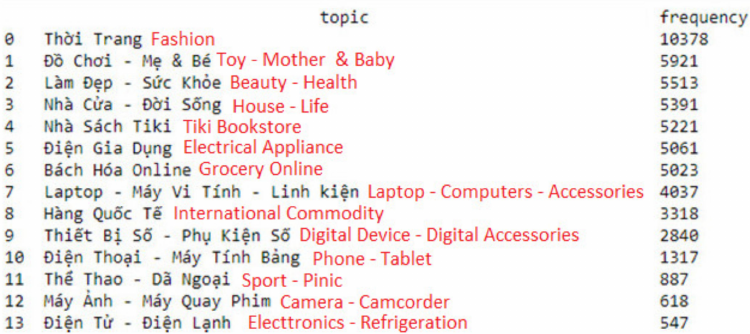
Figure 8. Statistics of reviews by category